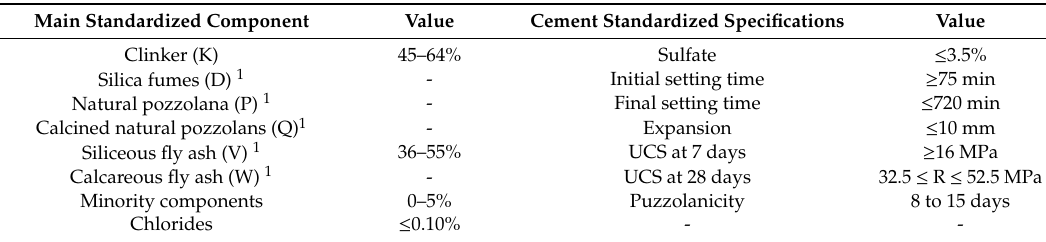
Table 3. Cement properties.